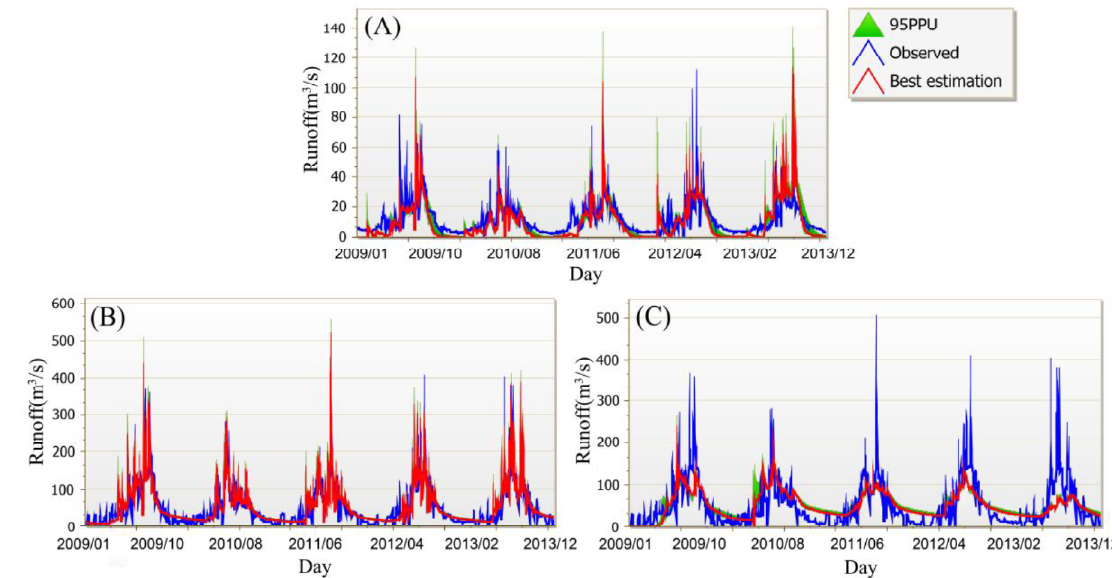
Figure 11. Simulation results of monthly average runoff of three different modes at Ying Luoxia control station from 2009 to 2013: ( A ) CMADS + SWAT mode; ( B ) TWS + SWAT mode; ( C ) CFSR + SWAT mode.